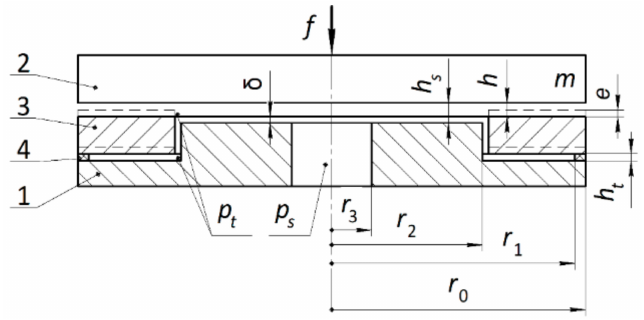
Figure 1. Design diagram of an adaptive stepped thrust